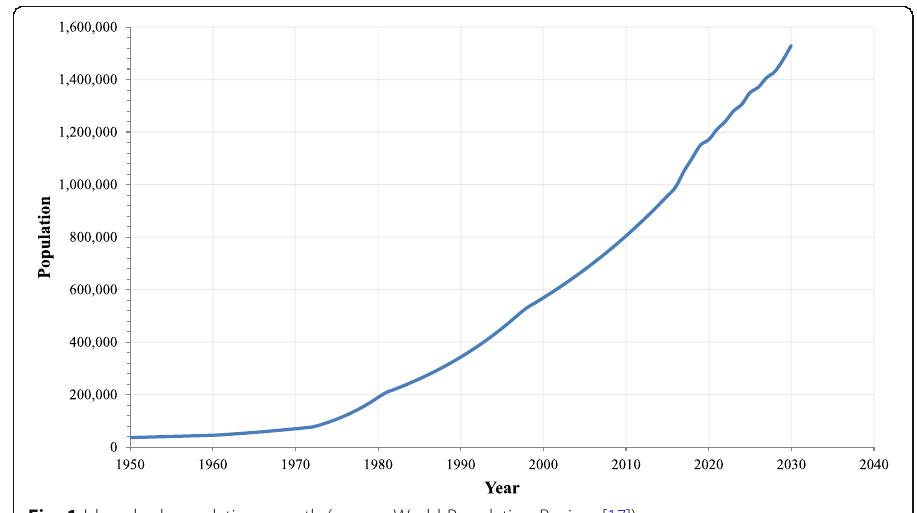
Fig. 1 Islamabad population growth (source: World Population Review